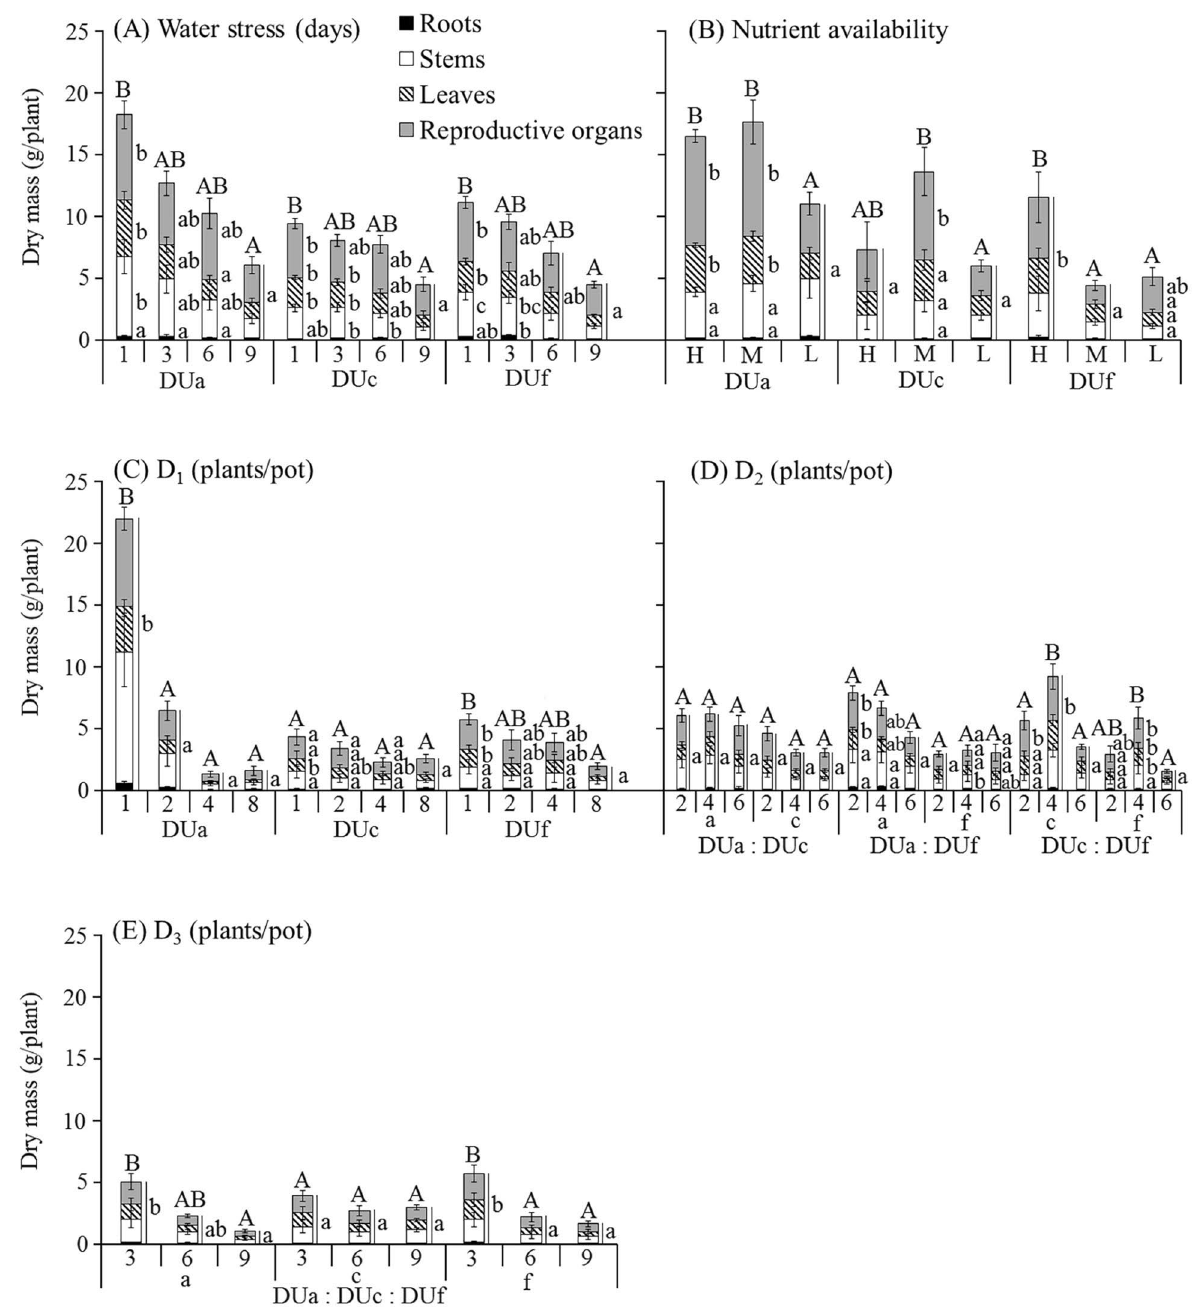
Figure 3. Effect of water stress ( A ), nutrient availability ( B ) and pure ( C ) and mixed ( D , E ) density on dry mass of roots, stems, leaves and reproductive organs of Ceratocarpus arenarius plants derived from each dispersal unit morph (mean ± 1 s.e.). Only masses ≥ 0.16 g and standard errors ≥ 0.09 g are shown. Different uppercase letters indicate significant differences in total plant mass and different lowercase letters significant differences in mass of roots, stems, leaves and reproductive organs among levels for all treatments of plants from the same dispersal unit morph ( P < 0.05). DUa, dispersal unit morph a; DUc, dispersal unit morph c; DUf, dispersal unit morph f; H, high; M, moderate; L,